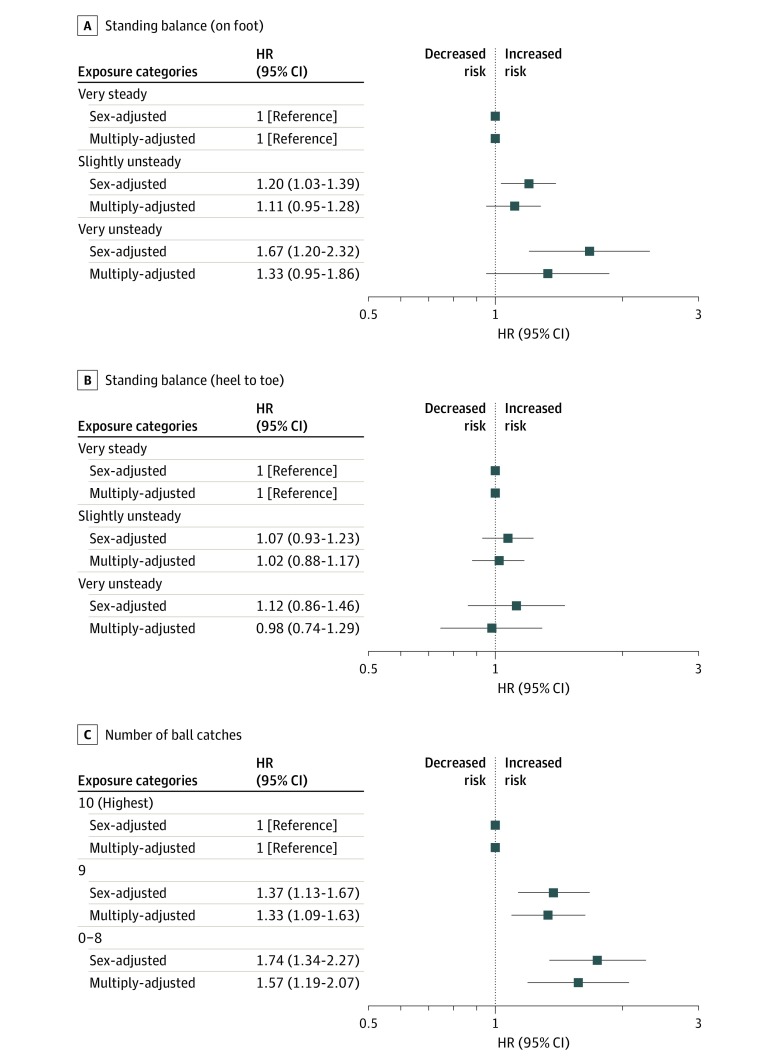
Association of Standing Balance (Foot and Heal-to-Toe) and Ball-Catching Tests at Age 11 Years With All-cause Mortality by 58 YearsTests were conducted for standing balance on foot (A), standing balance heel to toe (B), and number of ball catches (C). HR indicates hazard ratio; error bars, 95% CI. Multiple adjustment is adjustment for childhood socioeconomic, health, cognitive, and developmental factors as listed in Table 1.